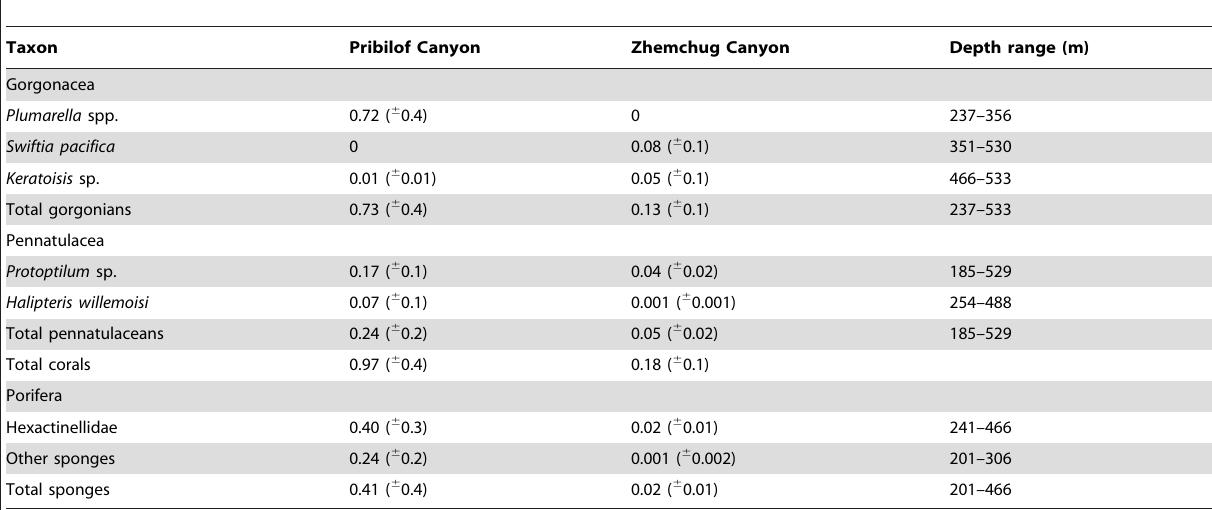
Table 1. Mean density estimates (numbers m 2 2 6 S.E.) and depth range of common corals and sponges in Pribilof and Zhemchug Canyons, Bering